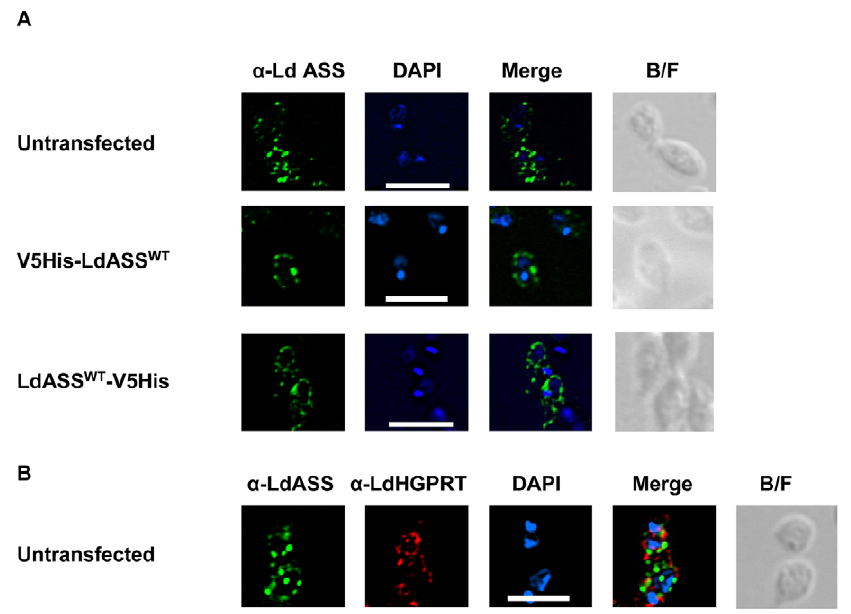
Figure 3. Immunofluorescence analysis of LdASS. L. donovani amastigote cells were stained with affinity purified antibody against LdASS as primary, and Alexa488-conjugated anti-rabbit IgG (green) as secondary antibodies. Panel A: upper row: untransfected parasites, middle row: V5His- LdASS WT transfected parasites, lower row: LdASS WT -V5His transfected parasites. Panel B: untransfected parasites labeled with biotinylated anti-LdASS (green) and anti-HGPRT antibodies (red). The nuclei and kinetoplast are stained with DAPI (blue). The merge of the images is shown in the column labeled ‘‘Merge’’ in the figure. The right panel shows the bright field images. The white bar represents the scale: 10 m m.